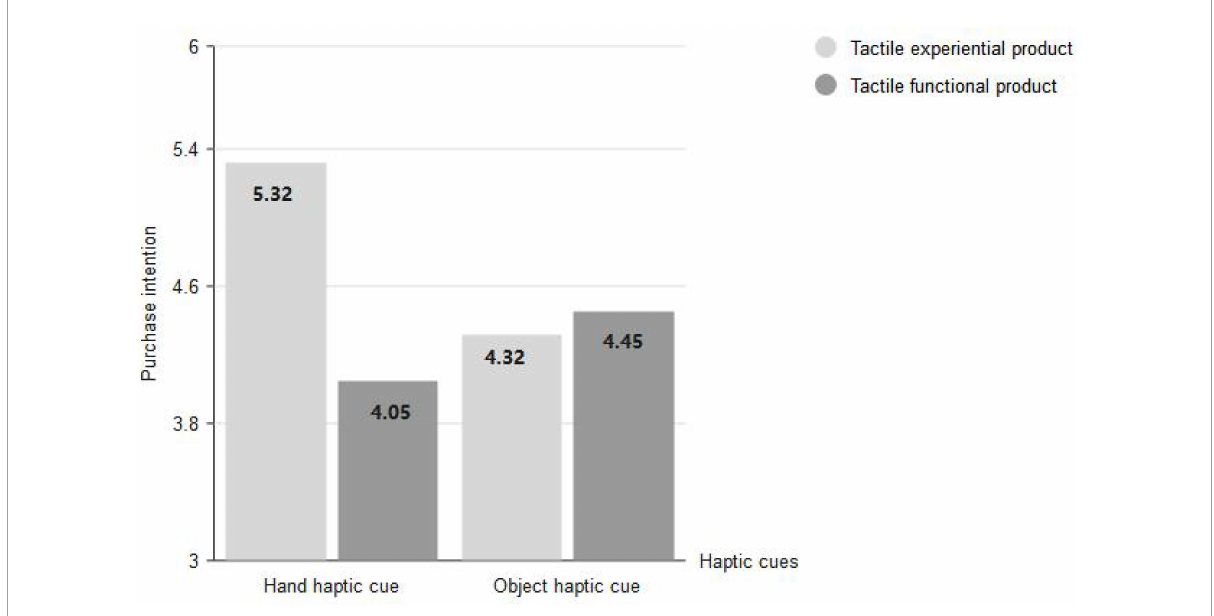
FIGURE5 Interaction effects between haptic cues and product